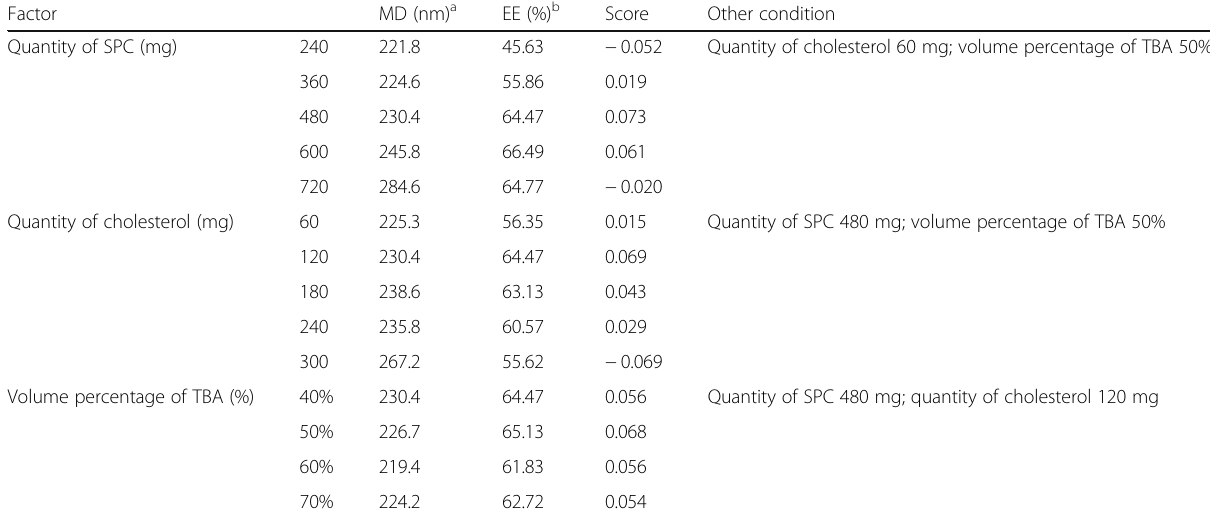
Table 1 Single-factor experiments